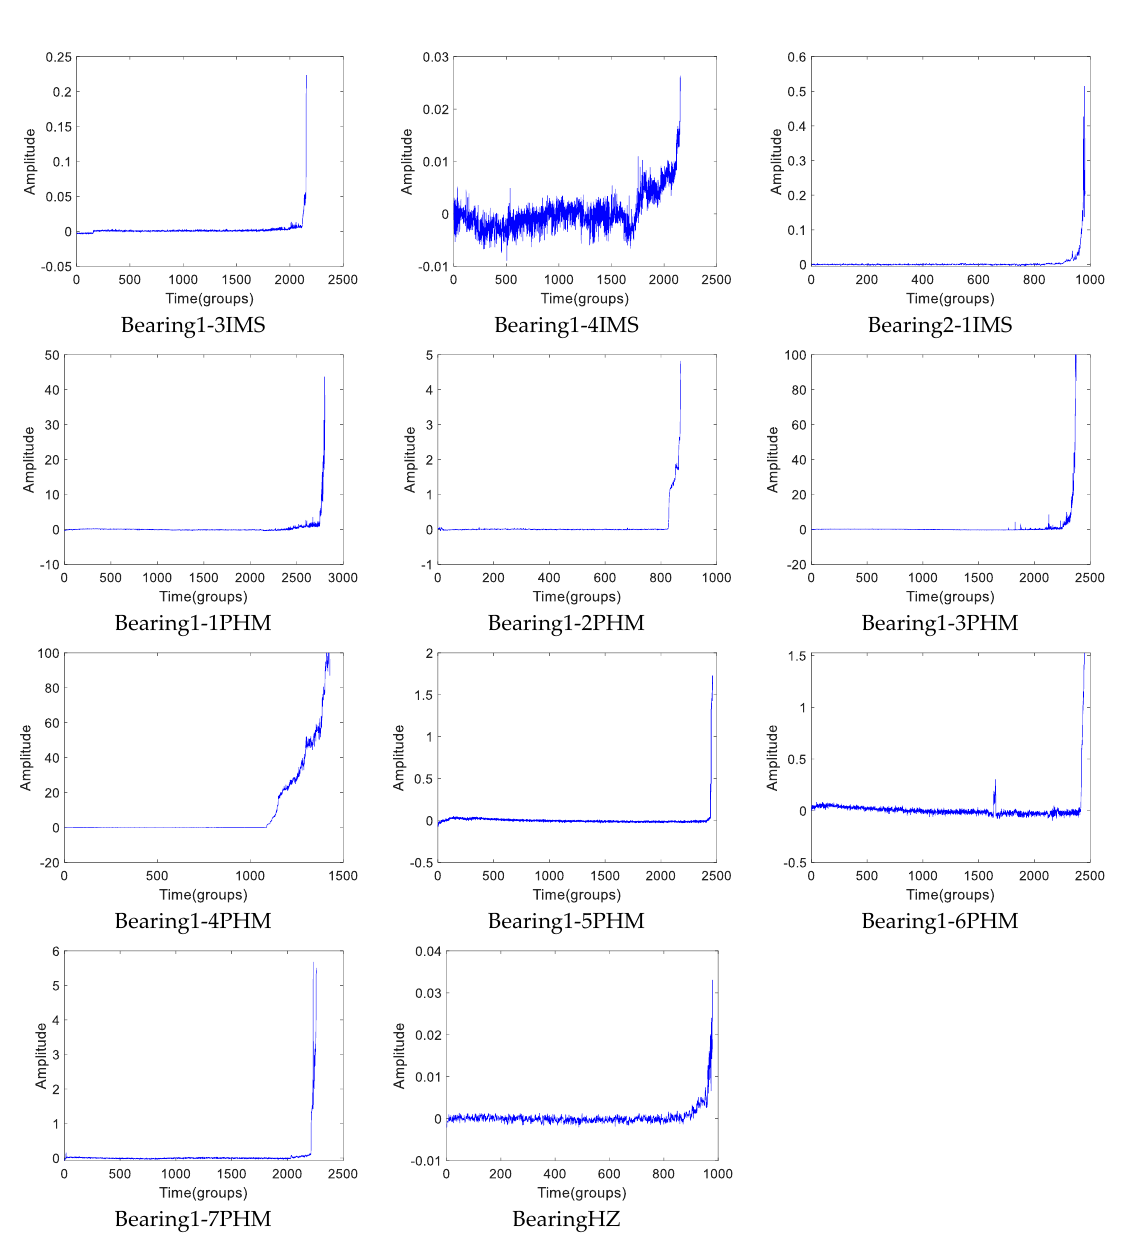
Figure 18. The novel health indicator of different run-to- failure rolling bearings’ data.